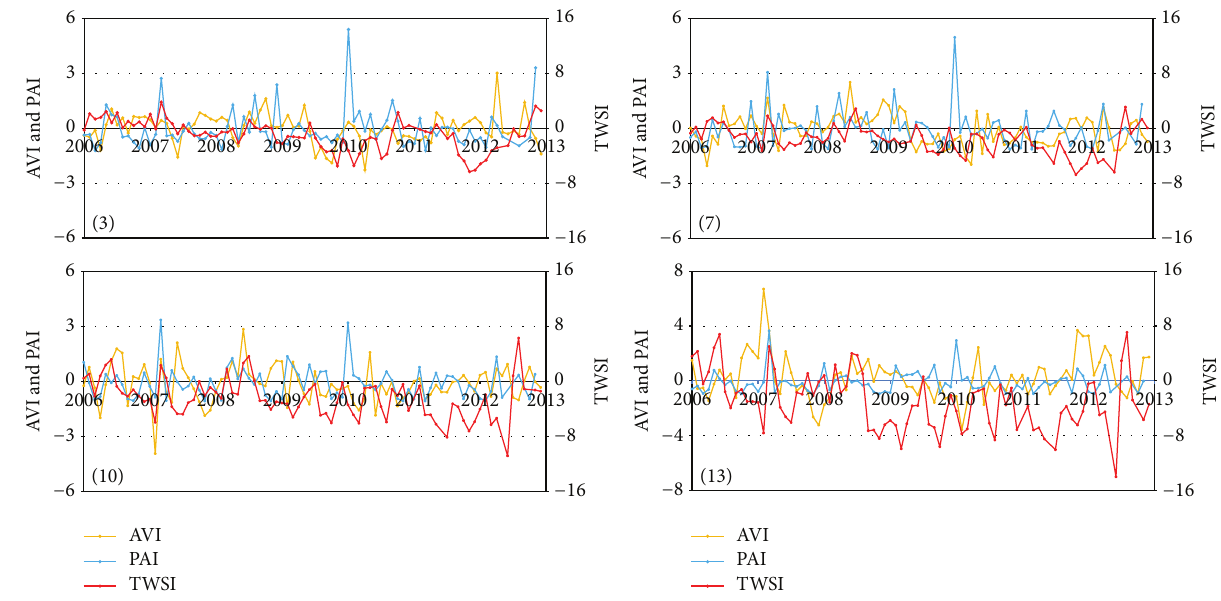
Figure 4: Time-series of the TWSI, the PAI, and the AVI for selected pixels.